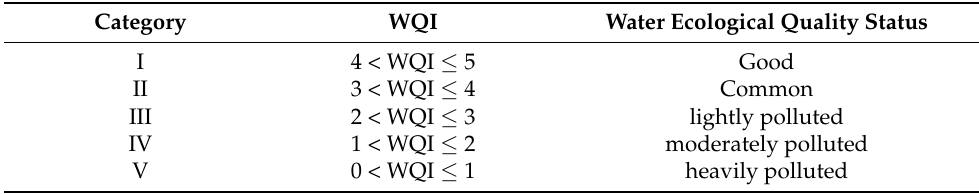
Table 3. Comprehensive index and grading evaluation standard of water ecological quality.